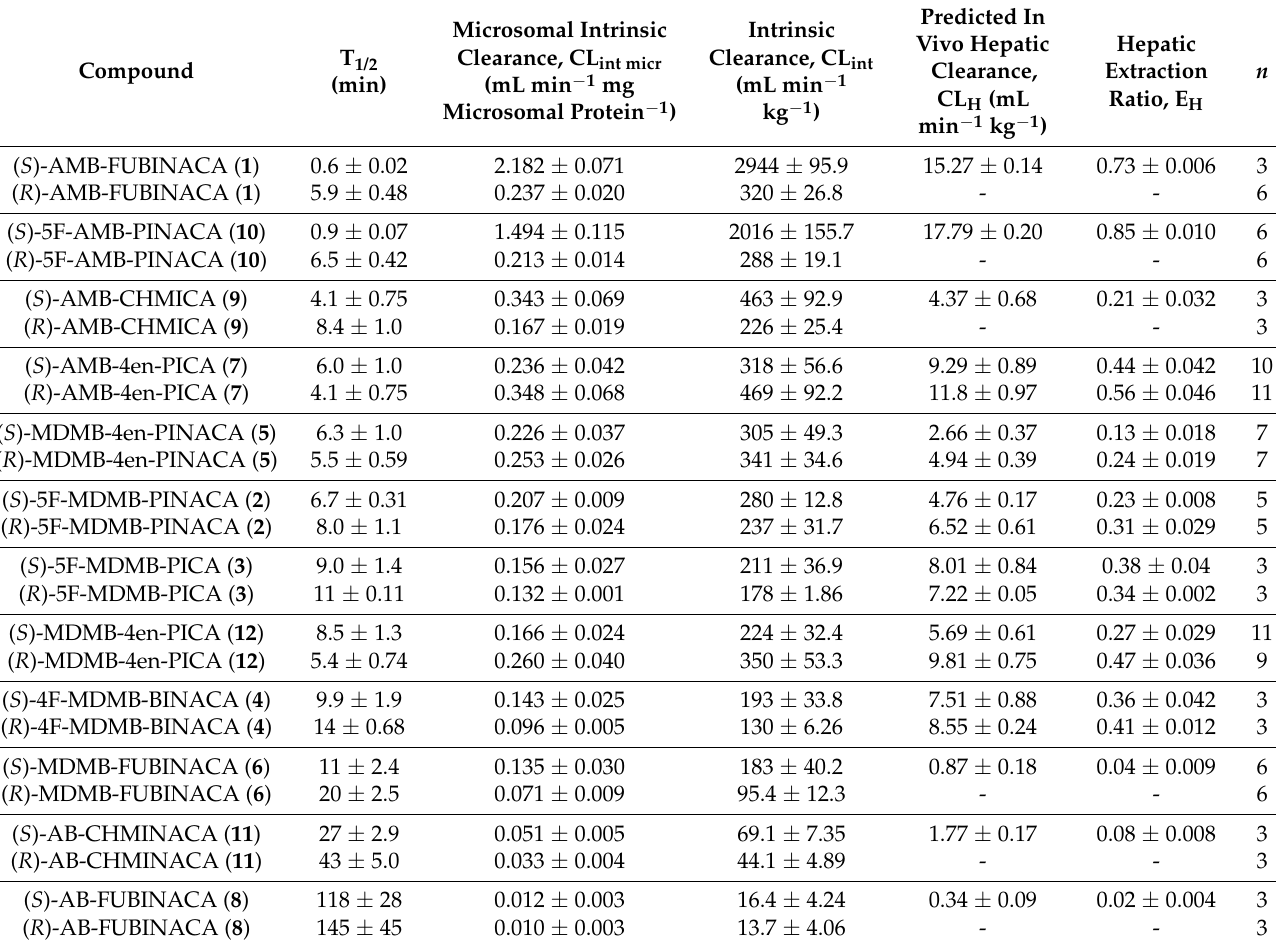
Table 4. In vitro half-life, microsomal clearance (CL int micr ) and intrinsic clearance (CL int ) with predicted in vivo hepatic clearance (CL H ) and hepatic extraction ratio (E H ) for pooled human liver microsome incubations ( n ≥ 3 ± SD). As plasma protein values are not available for some SCRA ( R )-enantiomers, hepatic clearance and hepatic extraction ratio values have not been calculated.